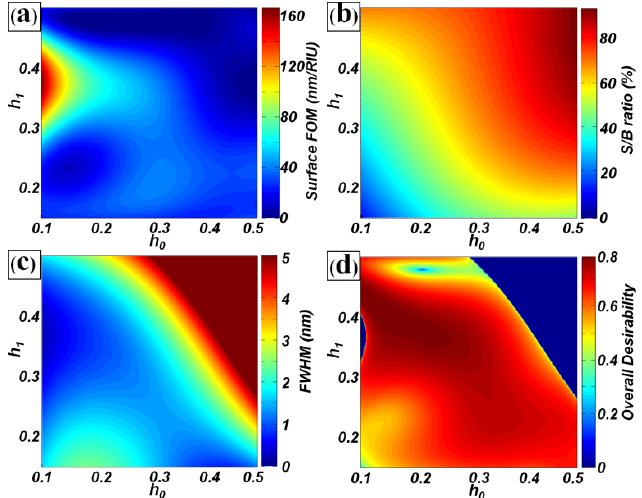
and h ( P = 550 nm and D = 0 1